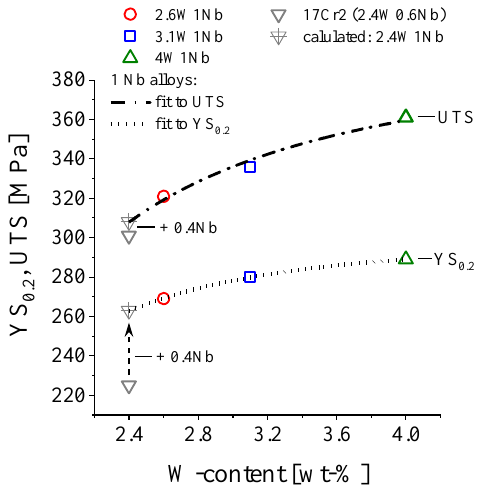
Figure 5. Solution effects of W and Nb on ambient temperature tensile strength values with (virtual 2.4W1Nb alloy, equation: YS 0.2 = a × (1 − c W−b ); c W : W-content in wt.%, a: 300.05, b: 2.38; UTS = a × (1